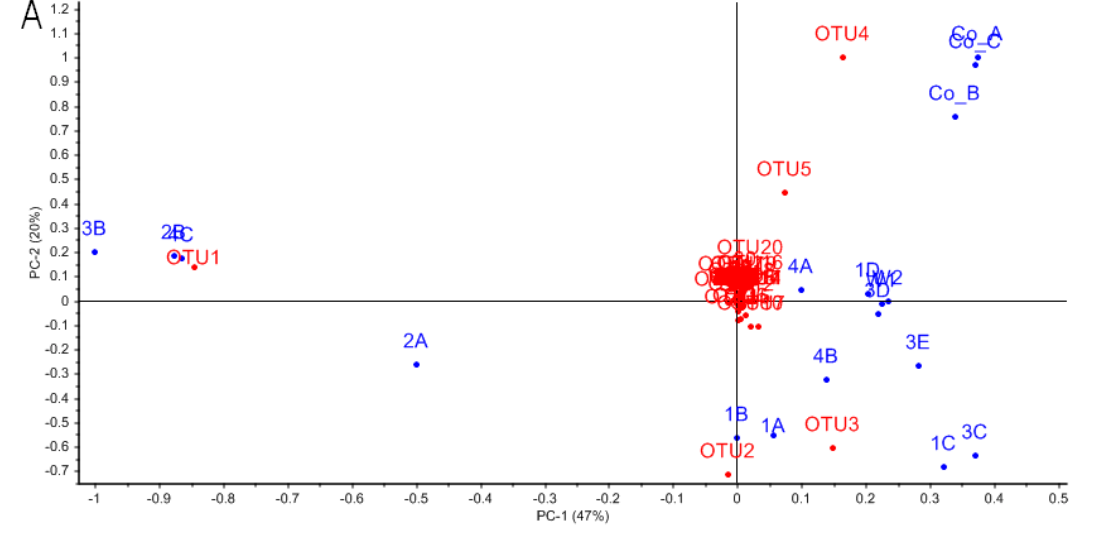
Figure 5. Cont . Figure 5.